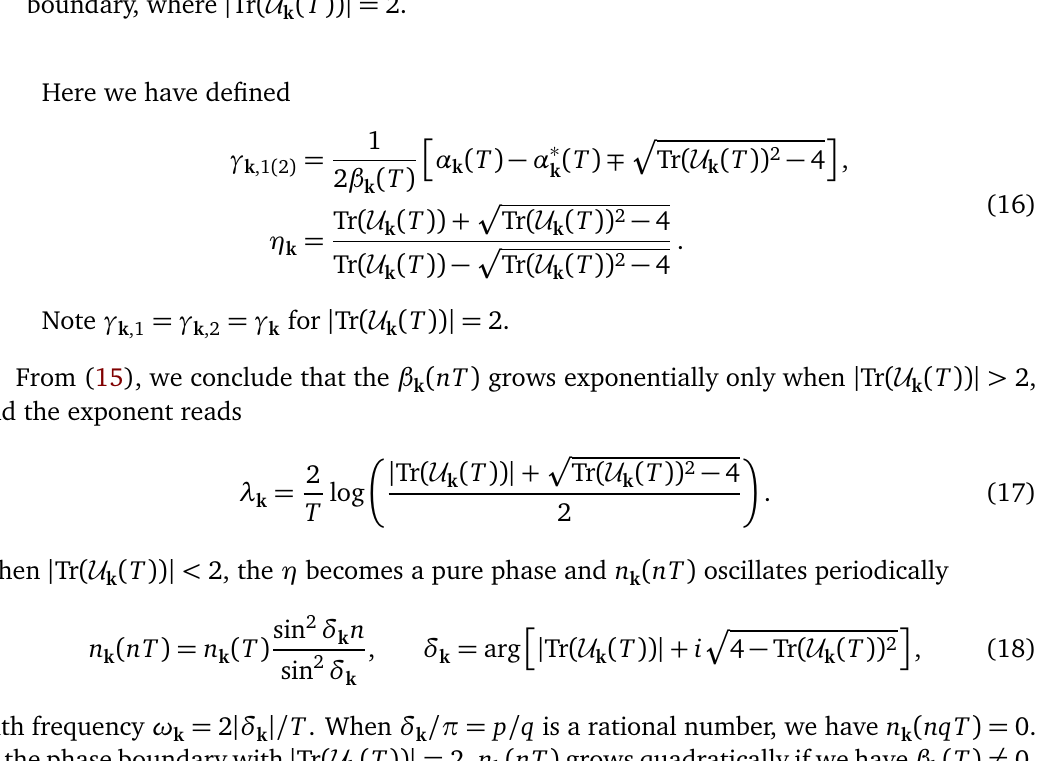
Figure 1: (a). The square-wave periodic modulation of the scattering length. Here = T = 0. (b). A density plot of | Tr ( U we choose the special case with T and g 0 1 1 = T = 0. This determines λ ( T )) | > 2 (heating phase) or for T and g for | Tr ( U k k 0 1 1 ω ( T )) | < 2 (non-heating phase). The dashed line denotes the phase for | Tr ( U k k ( T )) | = boundary, where | Tr ( U k